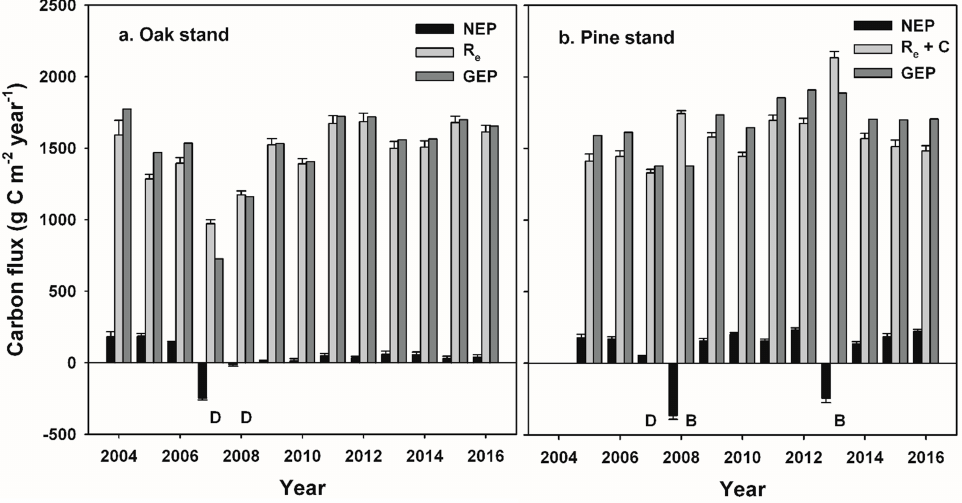
Figure 1. Net ecosystem production (NEP), ecosystem respiration (R e ) and combustion losses during prescribed fires (C), and gross ecosystem productivity (GEP) at the ( a ) oak and ( b ) pine stands. Error bars for NEP and R e indicate maximum deviations from mean annual NEP or R e values resulting from error analyses of gap-filling for missing half-hourly net ecosystem exchange of CO 2 (NEE) data. “D” indicates defoliation by gypsy moth and “B” indicates prescribed burns.